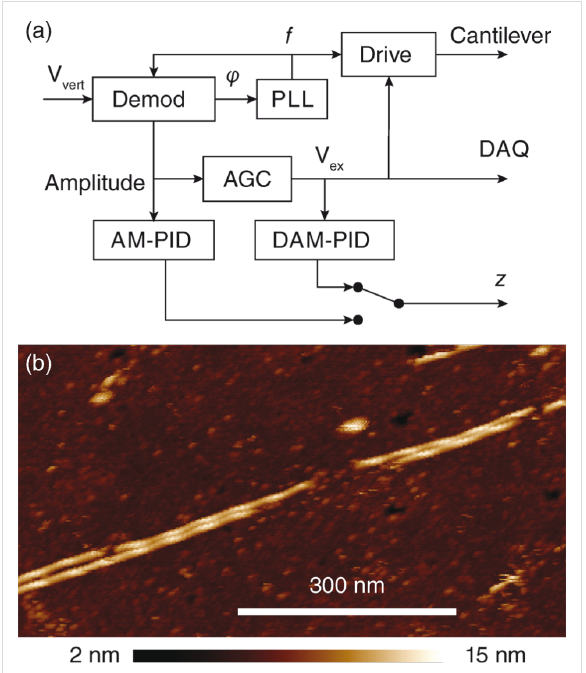
Figure 5: a) Schematic of the drive amplitude modulation feedback compared with standard amplitude modulation imaging. Instead of using the oscillation amplitude as feedback variable like in conven- tional amplitude modulation mode, the oscillation amplitude is kept constant and the drive amplitude required to keep it constant is used as feedback variable. The drive is then enforced to a setpoint above the free drive, resulting in a stable topography feedback. b) High-reso- lution DAM imaging in liquid of soft F-actin fibres on (3-aminopropyl)tri- ethoxysilane coated glass. Both the sub- and superstructure of the protein are